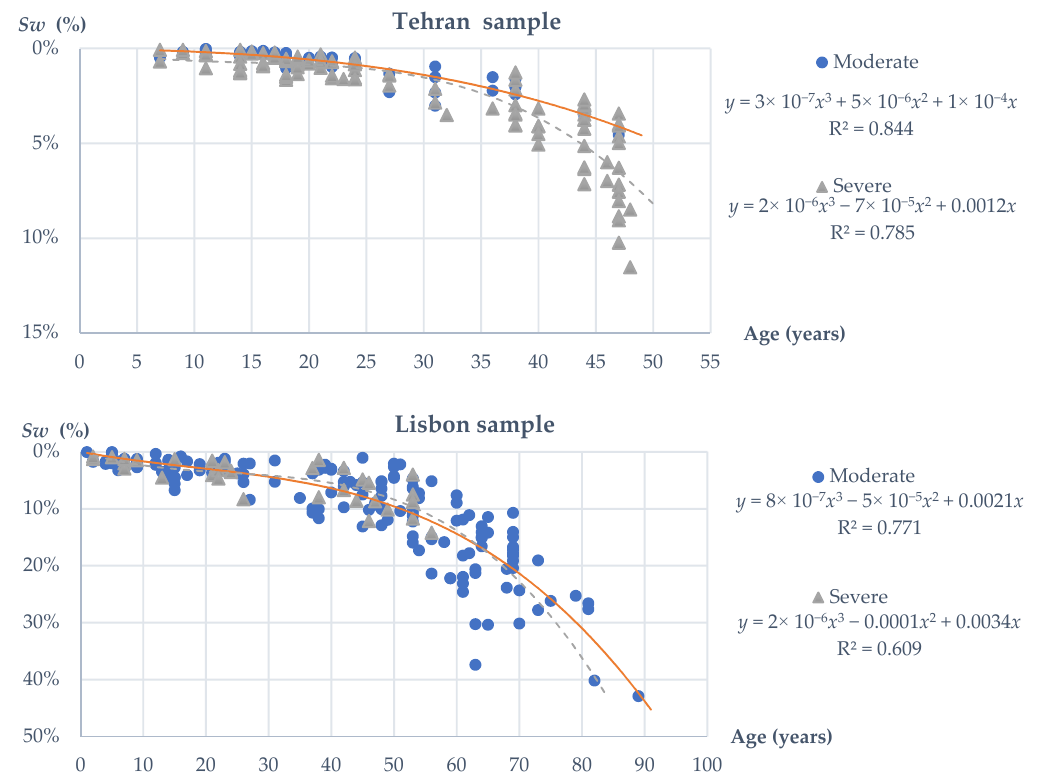
Figure 15. Degradation curves of the Tehran and Lisbon samples, according to the exposure to wind and rain action.